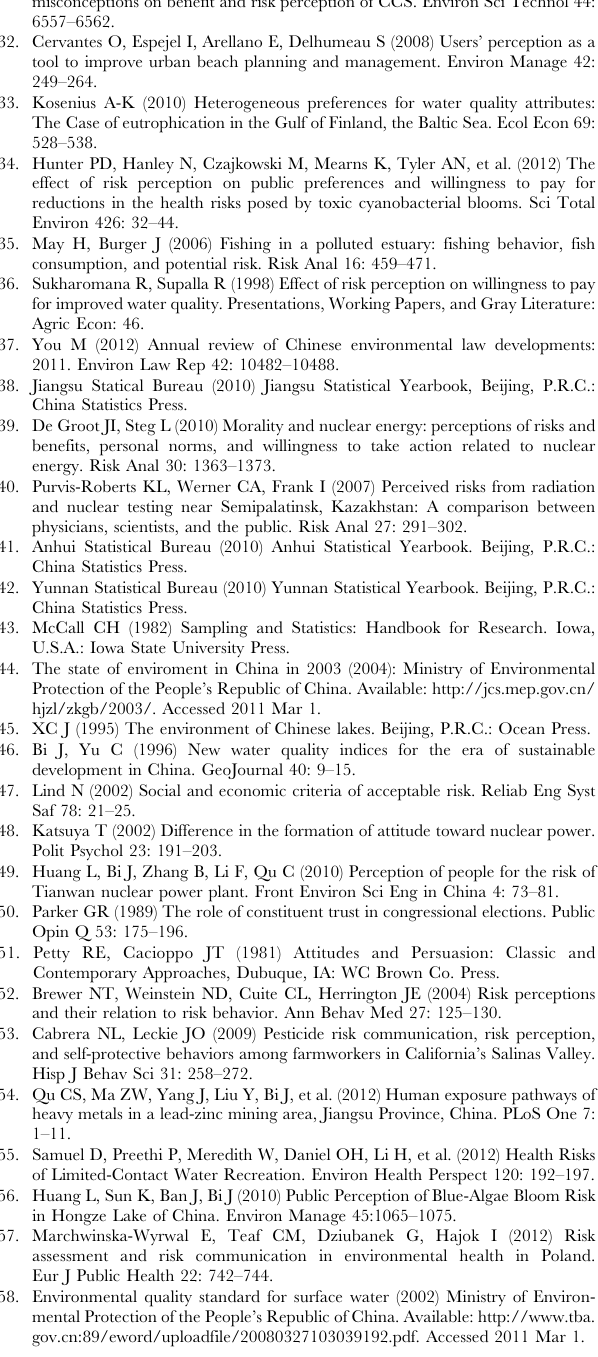
Table S3 Limit for Environmental Quality Standard for Surface Water